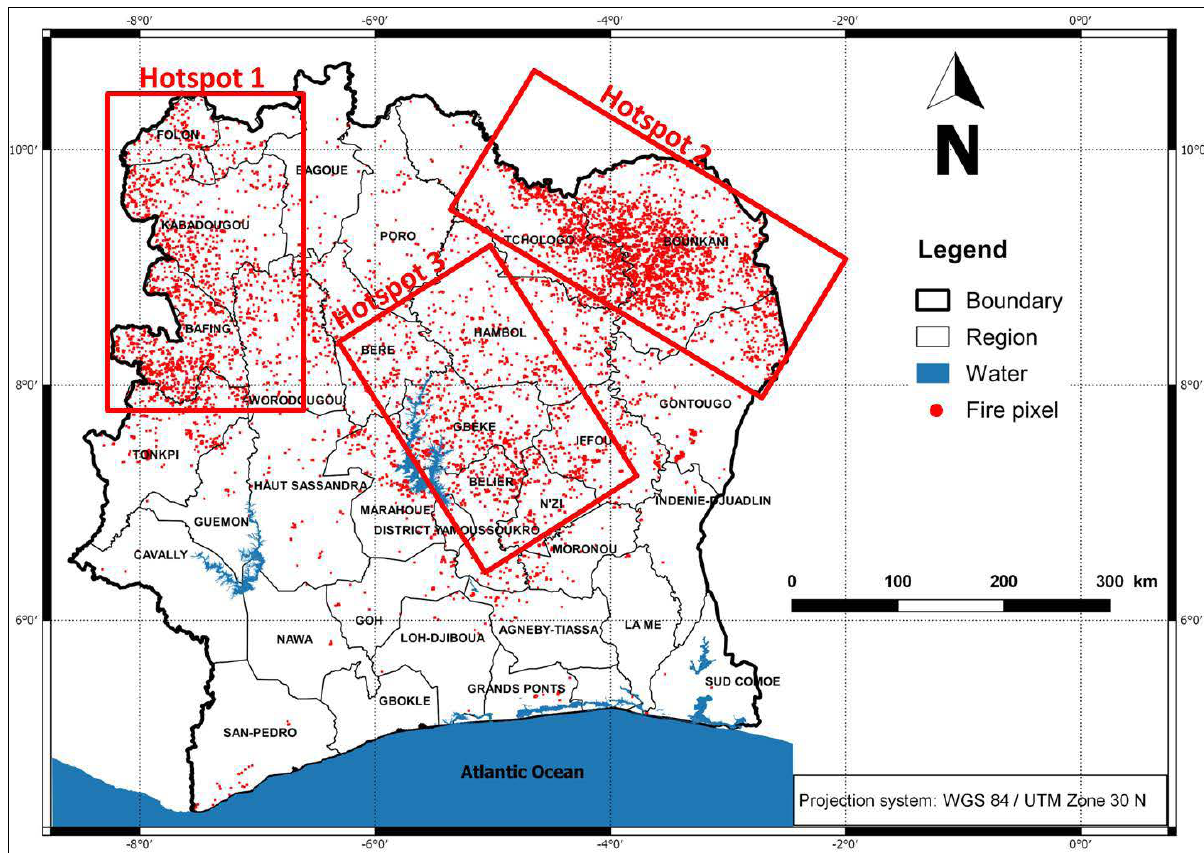
Figure 2: Map of the spatial distribution of active fires in Côte d’Ivoire showing main fire